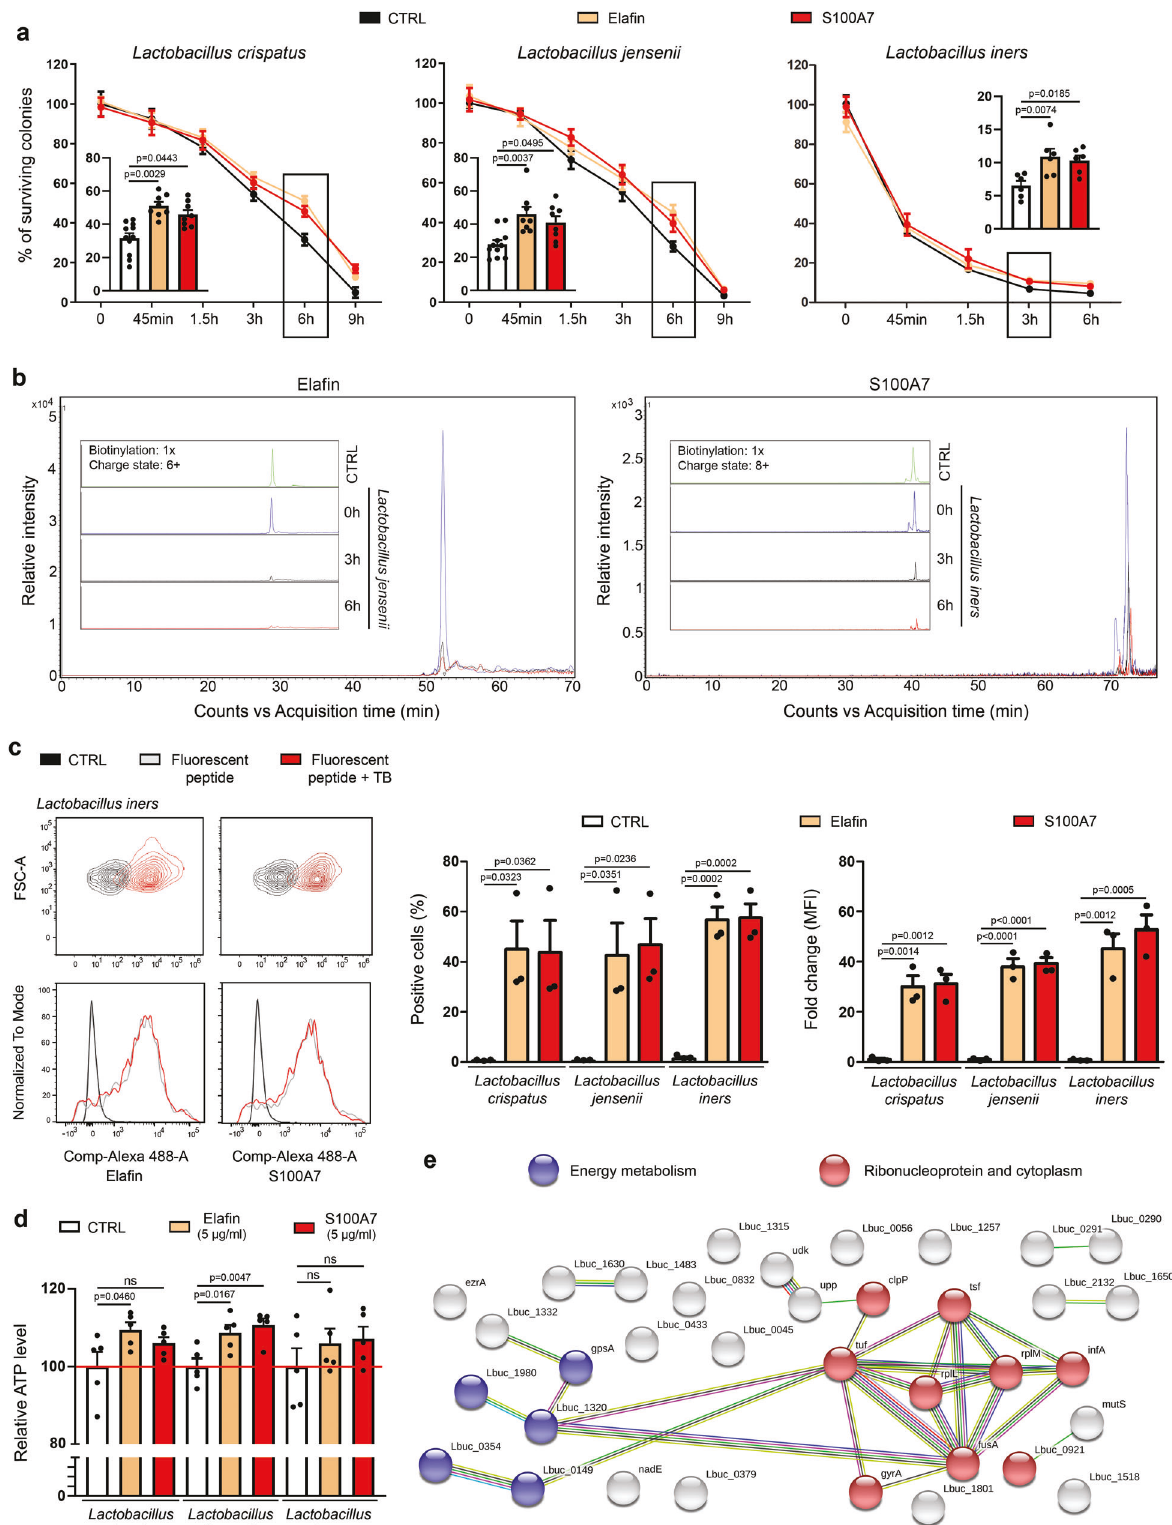
maturation of antigen-presenting cells 57 . Moreover, some defen- sins (most notably HD-5) have been demonstrated to block HPV infection via various mechanisms 58,59 . Therefore, the low HD-5 expression detected in infected epithelial cells could be particu- larly bene fi cial for the virus during the productive replication stage. Last but not least, this global decrease in innate